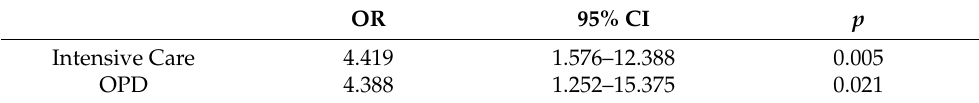
Table 9. Multivariate Analysis of Significant Risk Factors on Infection in the Univariate